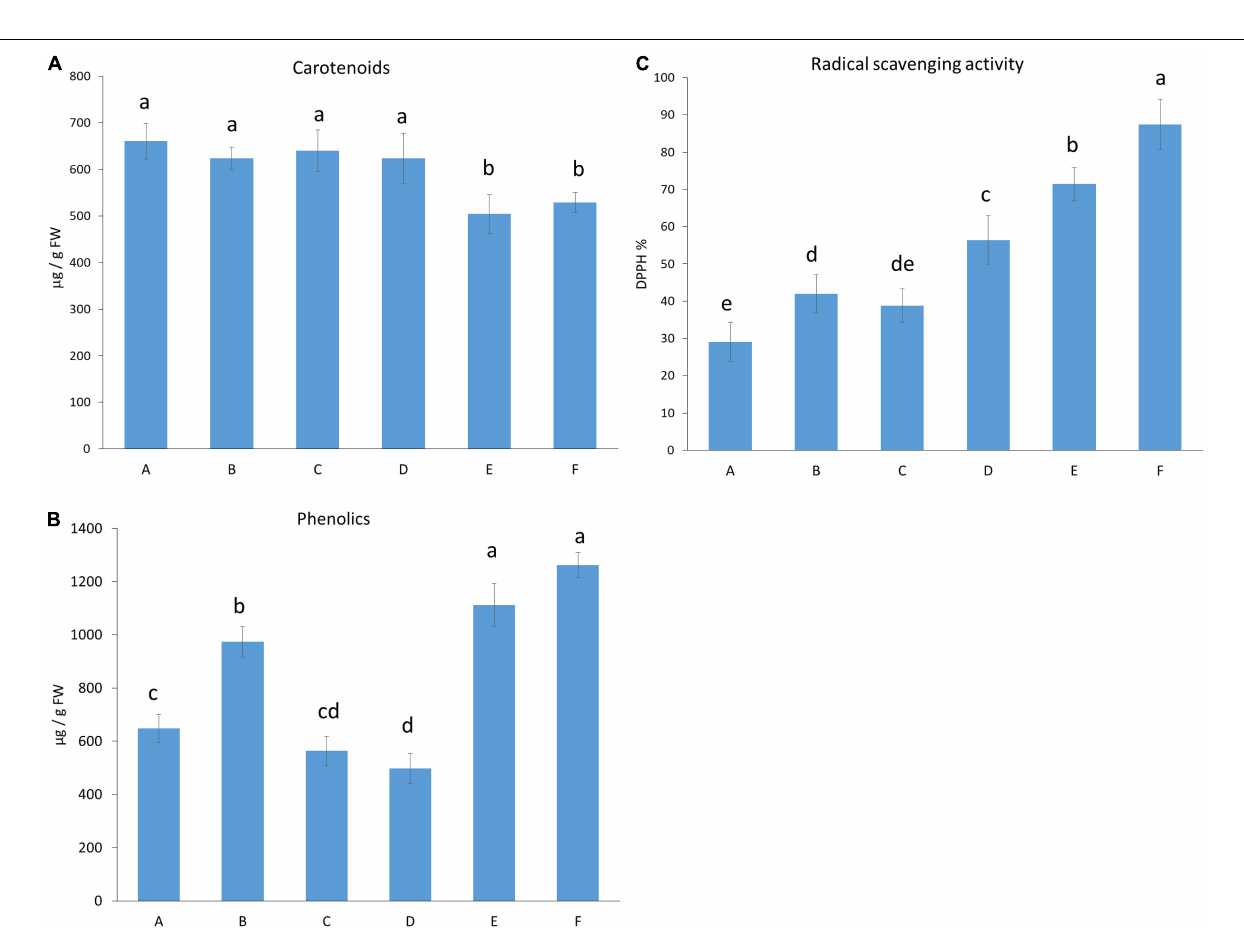
FIGURE 2 | Carotenoid (A) and total phenolic content (B) , and an antioxidant capacity of the fruit (C) . Light conditions used: (A) Application of red and blue LEDs with a 95:5 ratio at moderate (300 µ mol m − 2 s − 1 ) light intensity; (B) , utilisation of red and blue LEDs with an 80:20 ratio at (300 µ mol m − 2 s − 1 ) light intensity; (C) a wide spectrum with an average proportion of 65:20:15 of red:green:blue at moderate (300 µ mol m − 2 s − 1 ) light intensity: (D) a wide spectrum supplemented with far-red application in an average proportion of 65:20:15:0.6 of red:green:blue:far-red at moderate (300 µ mol m − 2 s − 1 ) light intensity; (E) , a wide spectrum supplemented with far-red application in an average proportion of 65:20:15:0.6 of red:green:blue:far-red at high (500 µ mol m − 2 s − 1 ) light intensity; (F) a wide spectrum supplemented with far-red and blue light application in an average proportion of 64:20:16:0.6 of red:green:blue:far-red at high (500 µ mol m − 2 s − 1 ) light